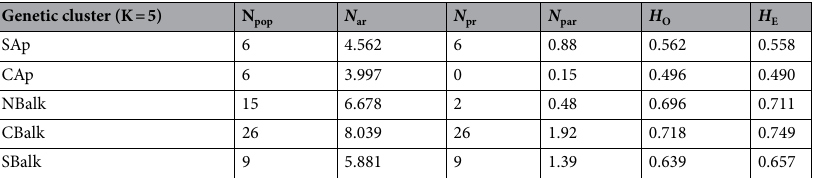
Table 1. Population genetic parameters of five S. officinalis genetic clusters as recognized by Bayesian model- based clustering analysis using STRU CTU RE. Genetic cluster (K = 5)—genetic clusters as recognized by STRU CTU RE software at K = 5. SAp, CAp, NBalk, CBalk, SBalk—clusters occupying the southern Apennines, central Apennines, northern parts of the western Balkans coastal region, central and southern parts of the western Balkans coastal regions including inland populations, and the southern Balkan Peninsula, respectively. Lat latitude, Long longitude, Npop number of populations included, N ar allelic richness, N pr number of private alleles, N par private allelic richness, H O observed heterozygosity, H E expected